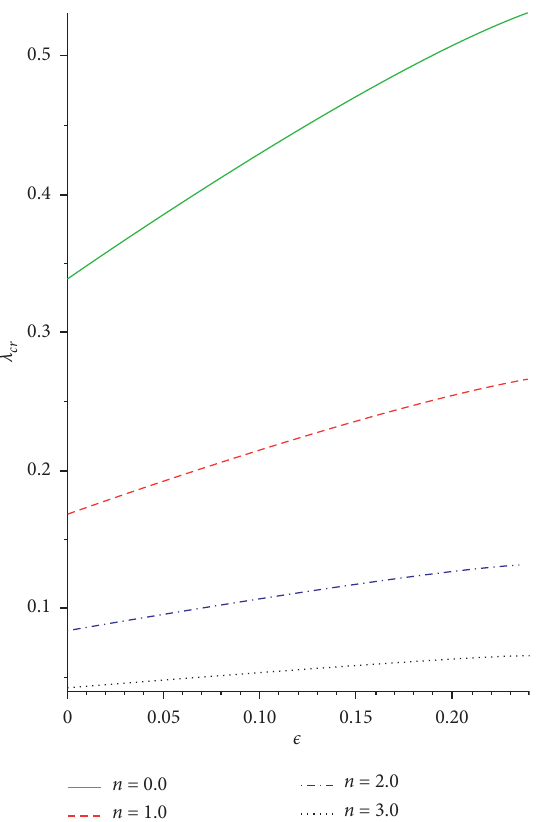
Figure 11: Plot of δ cr against ϵ for rising α